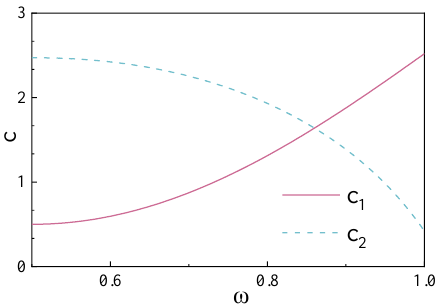
c as a function of  . Figure 6. Evolution of c 1 , c 2 as a function of ω c , 2 1